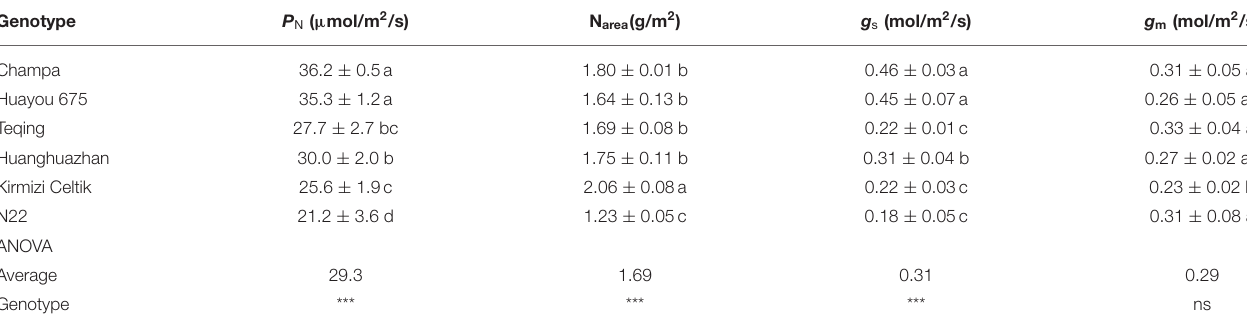
TABLE 1 | Gas exchange parameters and area-based leaf nitrogen content (N area ) of the six rice genotypes. Genotype